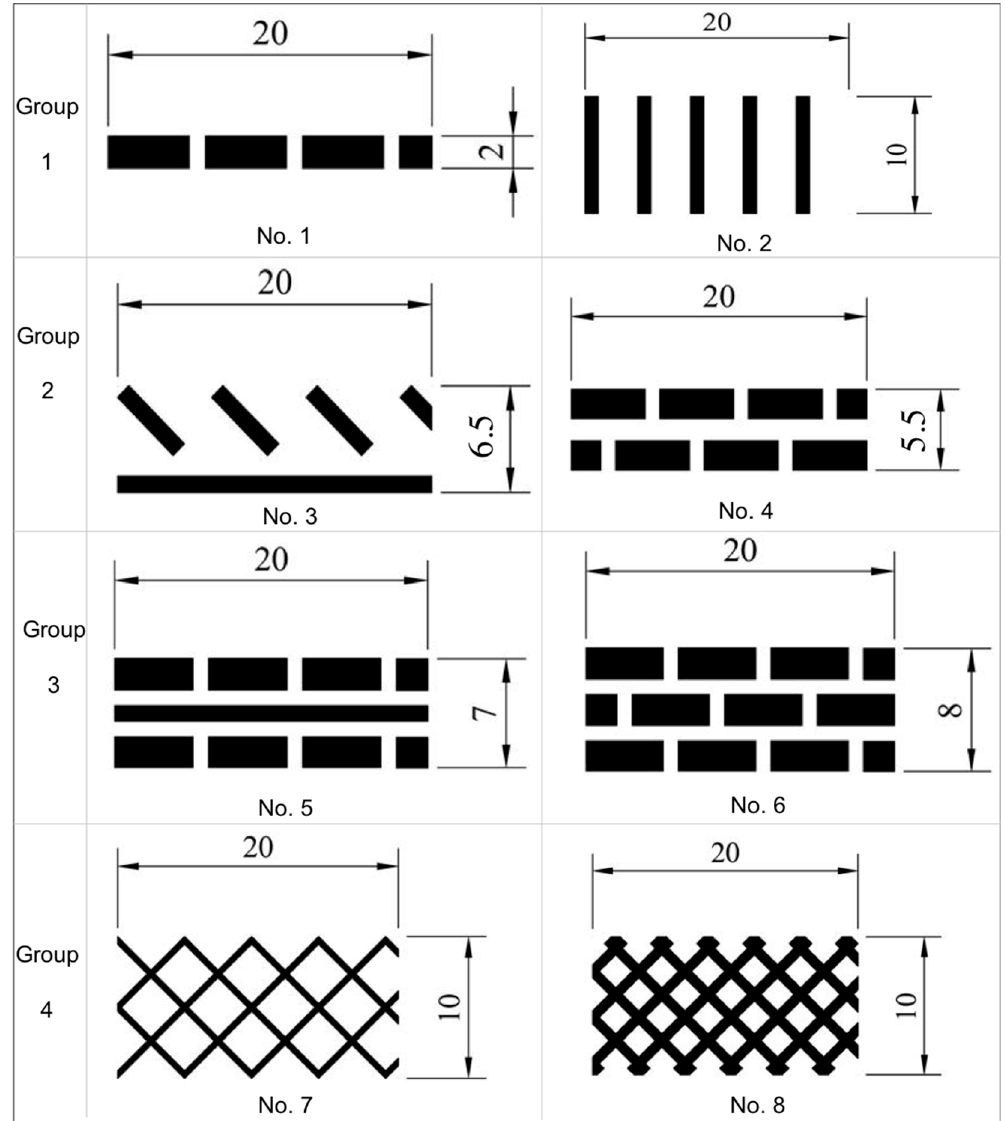
Figure 5. Designation of the roller patterns.